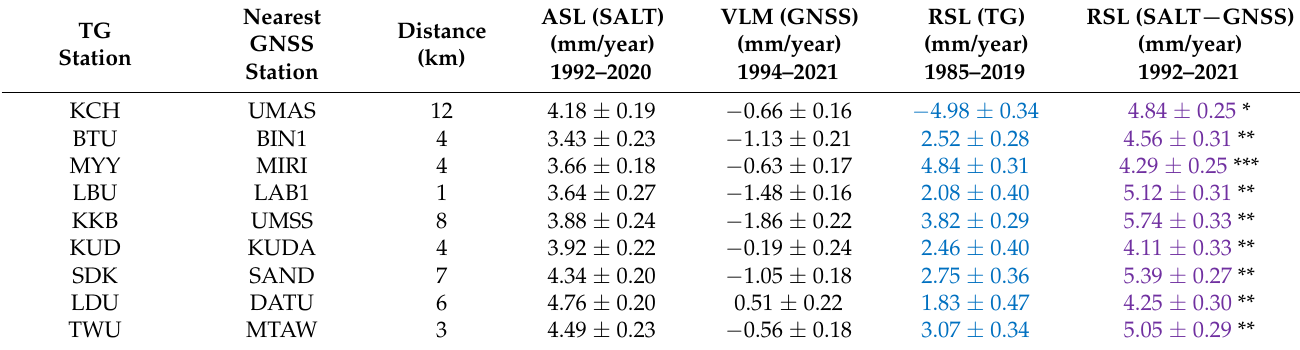
Table 9. RSL comparison (TG versus SALT − VLM) for 9 locations in East Malaysia. Shown are the final ASL, VLM (from the nearest GNSS station), RSL (from TG), and RSL (from SALT − GNSS). In blue and purple, the RSL values to be compared are highlighted. The distance from the TG to the nearest GNSS station is also given. All error estimates are given at a 95% confidence level (1.96